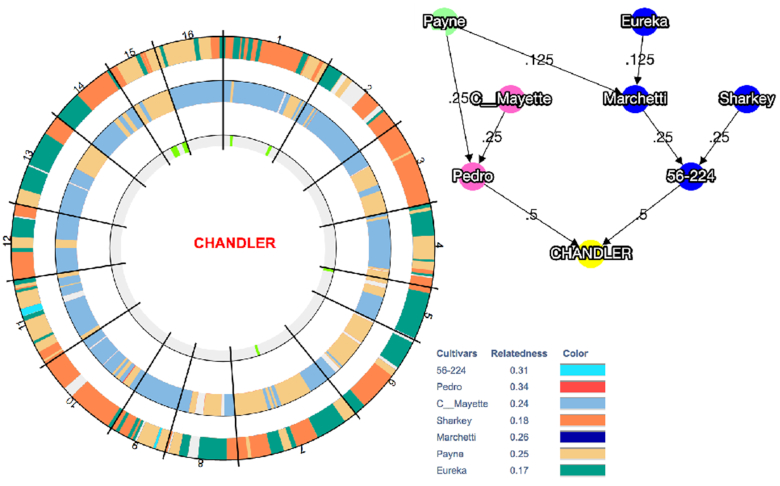
Graphical visualization of the haplotype block (HB) inheritance across Chandler pedigree in the 16 chromosomes. The inner circle highlights in grey the regions of heterozygosity and in light green the regions of homozygosity for each chromosome. The circle in the middle shows the maternally inherited HBs, while the HBs inherited from the paternal line are visualized in the outer circle. In both parental line circles, missing data are highlighted in grey. Payne haplotypes are inherited along both parental lines in all chromosomes but Chr5, Chr9, Chr10, Chr14, and Chr16. Chandler pedigree is represented on the side, where Pedro is the maternal line and 56–224 the paternal line.